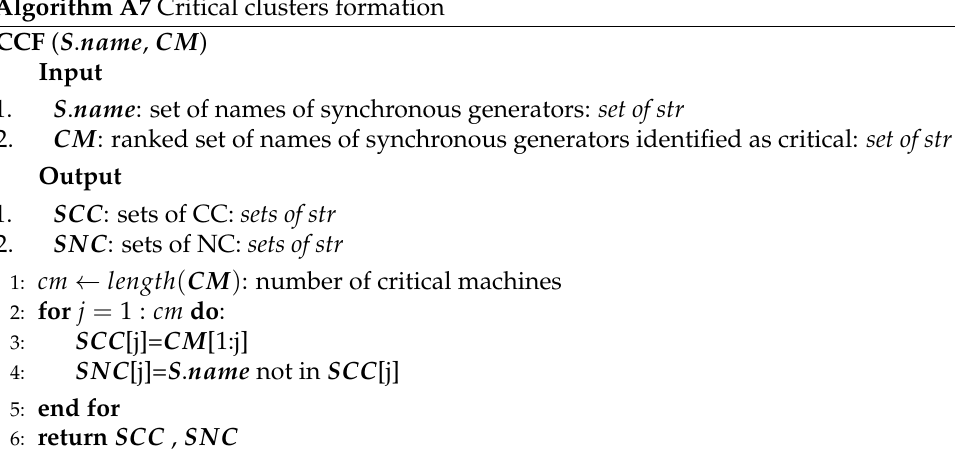
Algorithm A7 pseudocode details the function to form different candidate CCs and NCs. This pseudocode represents a simple method among others. For cm critical machines, the algorithm selects cm candidate CCs composed of the first from the top, the first two from the top, ..., up to all cm machines in the CC set. It outputs the set of candidate CCs and the set of candidate NCs. Algorithm A7 Critical clusters formation